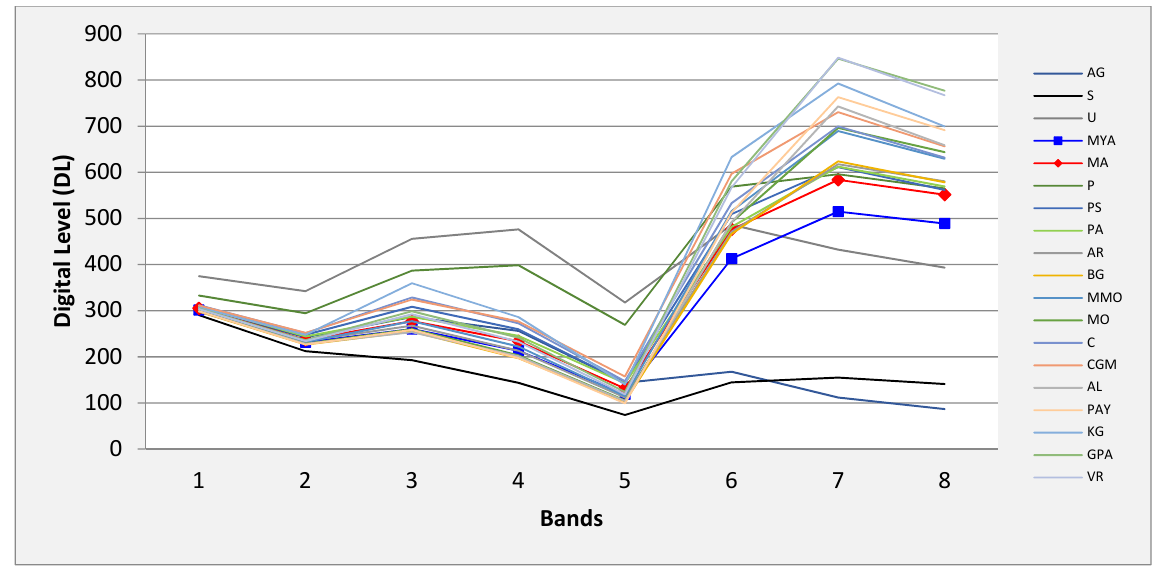
Figure 2. Spectral signatures of different vegetation and land-use categories in the WorldView-2 Image of Trinidad-Valle de los Ingenios, Cuba.